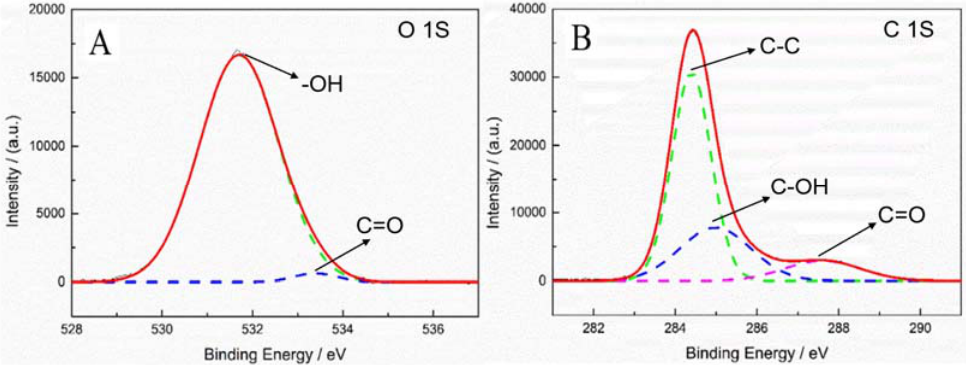
Figure 11. Fiber surface element analysis of XPS spectra of the fiber treated by method F ‐ b. ( A ) O 1S, ( B ) C 1S.